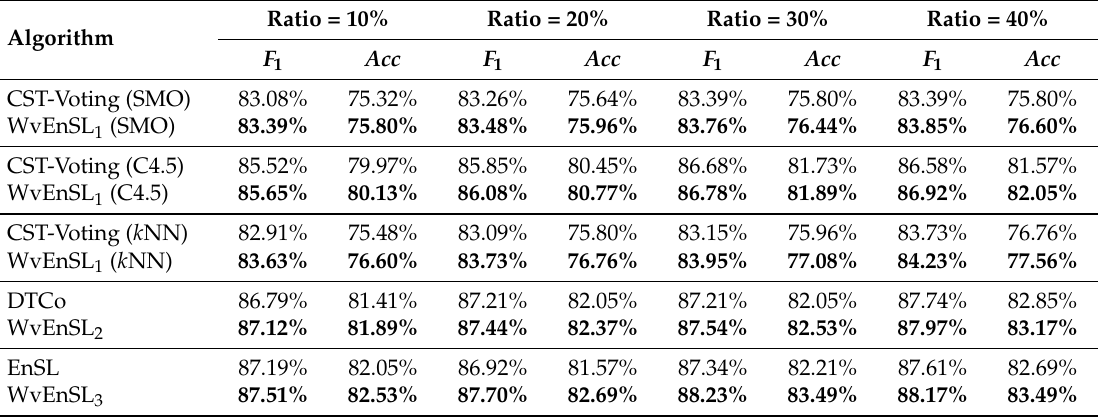
Table 2. Performance evaluation of WvEnSL against ensemble self-labeled algorithms for Pneumonia dataset.